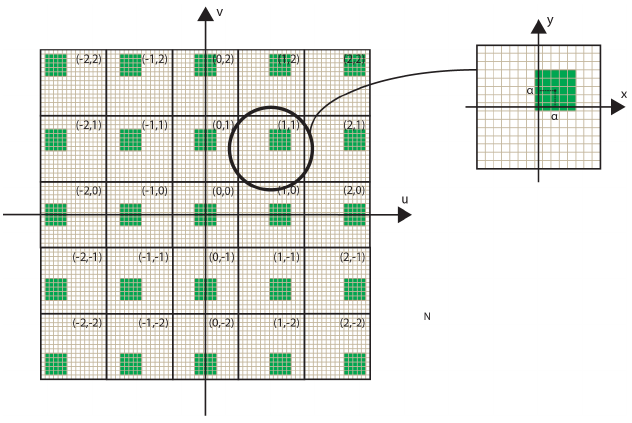
Figure 2. The EIs cropping. In the classical ( u , v , x , y ) parameterization of the integral image,